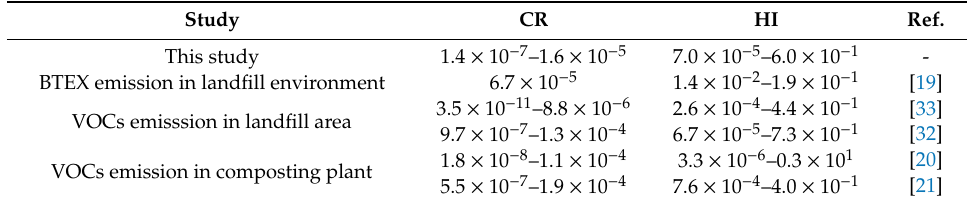
Table 4. Comparison of CR and HI values obtained in this study with other